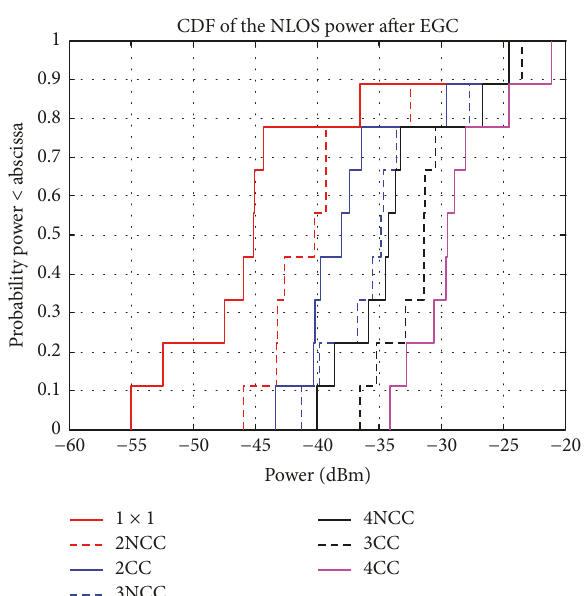
Figure 10: CDF of receiver spatial diversity after applying CC and NCC schemes for the NLOS scenario.